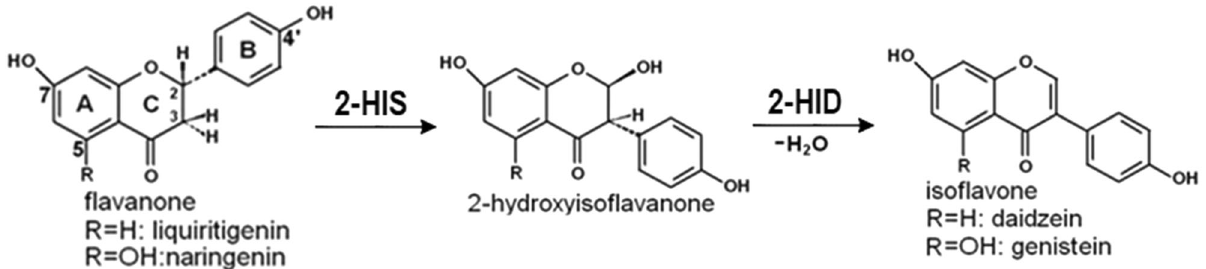
Fig. 1 The enzymatic reactions catalyzed by 2-HIS and 2-HID. 2-HIS catalyzes hydroxylation and aryl-ring migration of fl avanones (e.g., liquiritigenin and naringenin) to convert them to 2-hydroxyiso fl avanones, and 2-HID then catalyzes dehydration of 2-hydroxyiso fl avanones to yield the fi nal iso fl avone products, e.g., daidzein or